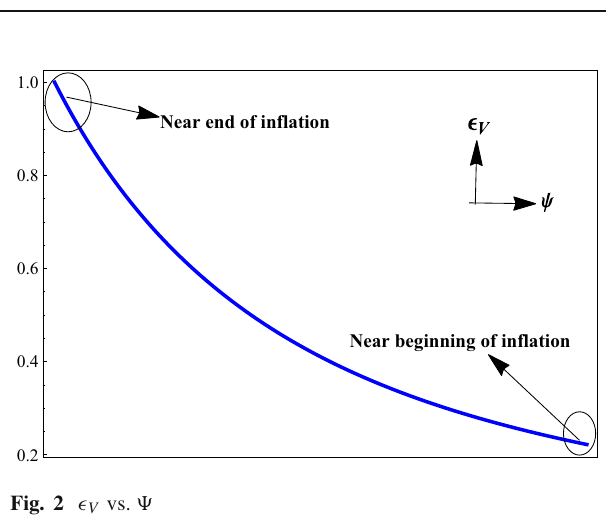
Fig. 2 (cid:15) V vs. (cid:13)